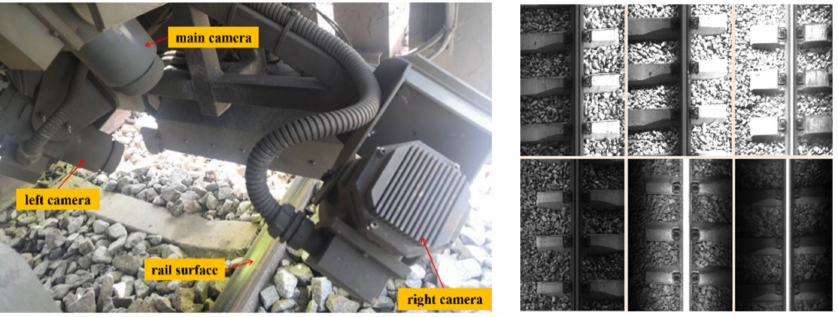
Figure 1. Image acquisition system.